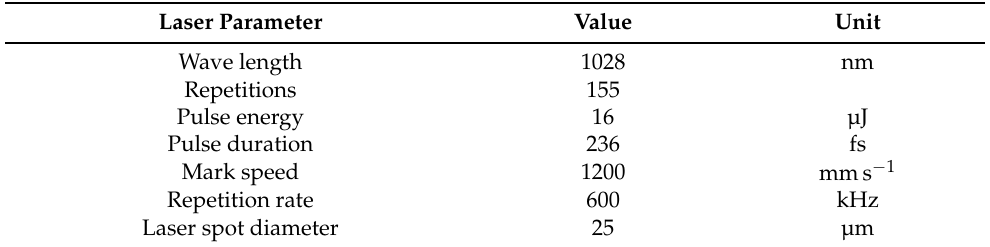
Table 1. Laser fabrication parameters for cutting groves into 100µm thick stainless-steel sheet metal.